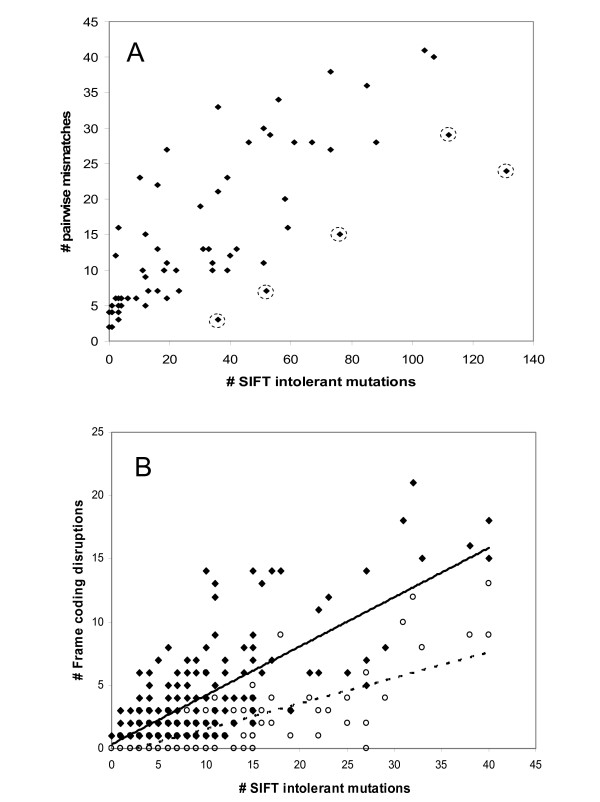
SIFT matrix validation. A. The number of SIFT intolerant mutations in each conserved positions (X axis) are plotted vs. their corresponding pair-wise mismatches count of the positional conservation score calculation. Except the large differences in five positions (49, 123, 149, 185 and 262 marked in circles) there is a high agreement between the two methods (r = 0.73 P < 10-5). (B) The number of SIFT intolerant mutations (X axis) in each of 245 human OR pseudogenes are plotted against the number of coding frame disruptions in their sequences (filled squares) Overall, a high positive correlation is observed even when only frame disruptions between TM1-TM7 are considered (empty circles) (r = 0.75 P < 10-5, r = 0.73 P < 10-5 respectively). Thus, the data in these plots suggests that the SIFT matrix is a good indicator for deviation from selective constraints.